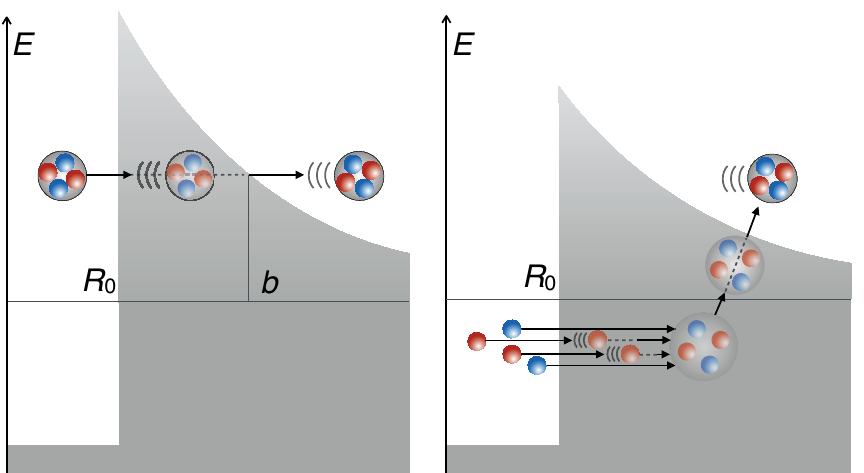
Figure 1. Schematic view of the extreme situations in which an alpha-particle could escape a nucleus. Left : Tunneling of a single pre-formed alpha-particle through the barrier. In this case, the alpha-particle is preformed through correlations arising from the interaction between nucleons inside the nucleus. Right : Tunneling of individual nucleons with the alpha-particle being post-formed outside the nucleus due to correlations of the four-nucleon interaction and the mean field of the daughter nucleus at the barrier region. The advantage here is that the Coulomb potential for protons is lower than that for α -particles and there is no Coulomb barrier for